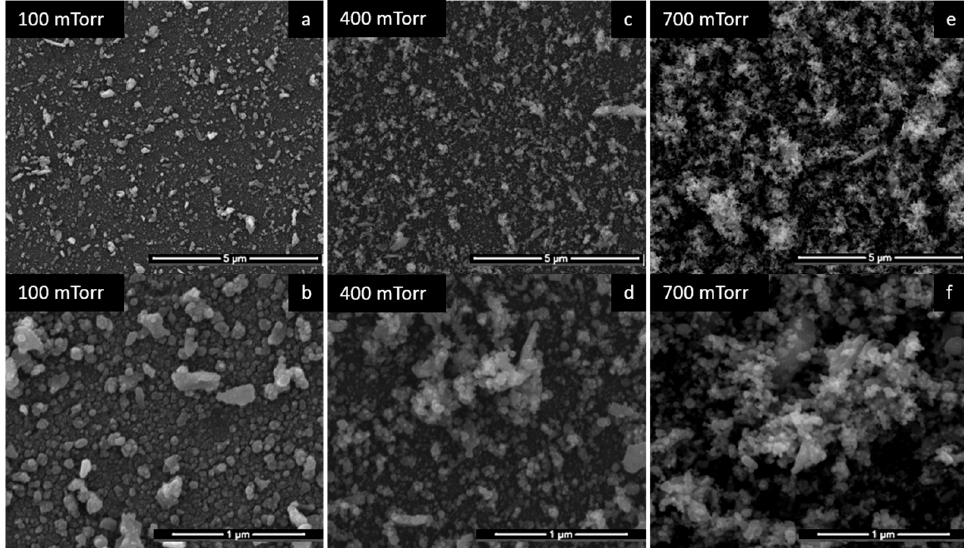
Figure 2. SEM images of SnO 2 films deposited at different gas pressures.